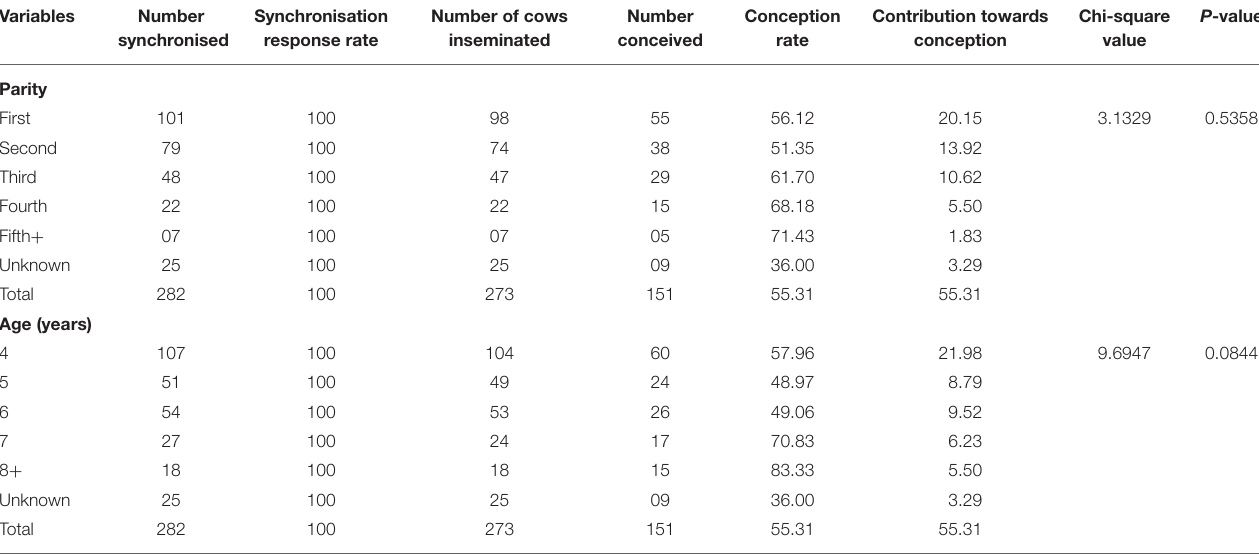
TABLE 3 | Effect of parity and age on synchronisation response and conception rate of cows under communal and emerging farming systems. Variables Number